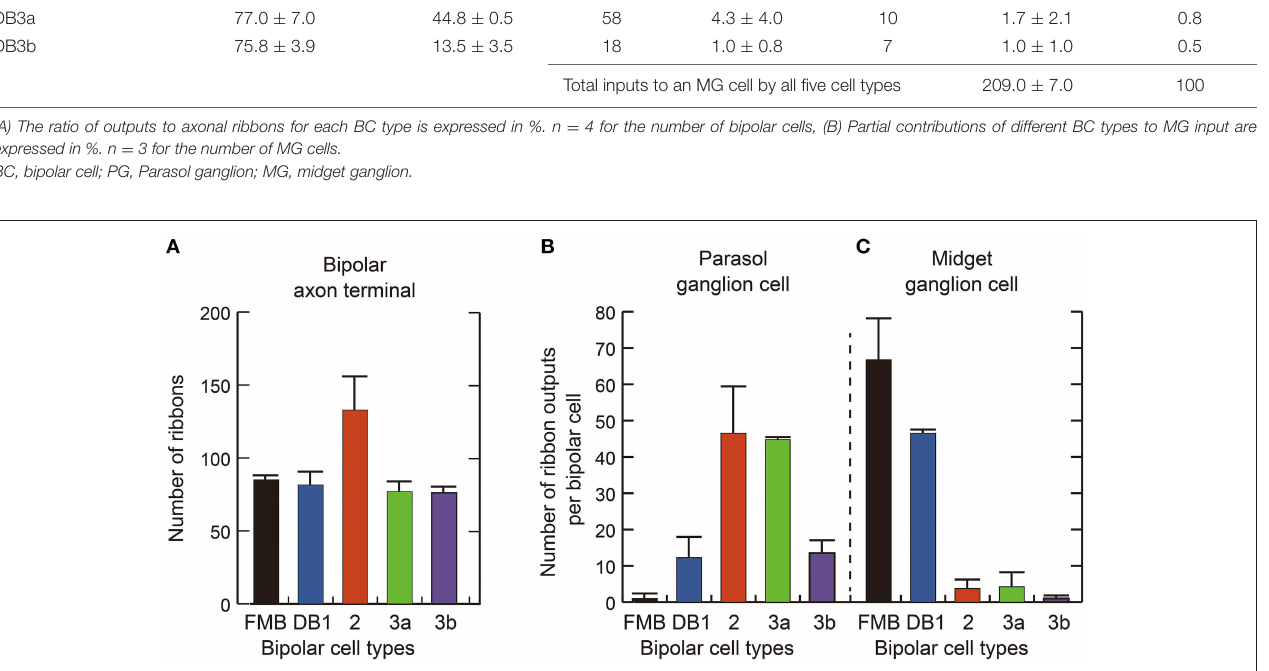
FIGURE 10 | Quantification of OFF bipolar ribbon synapses with parasol and midget ganglion cells. (A) Mean number of synaptic ribbons in the axon terminals of each type of OFF bipolar cell. (B,C) Mean number of ribbon synaptic contacts with parasol (B) and midget (C) ganglion cells. Data are mean ± SD of four cells of each